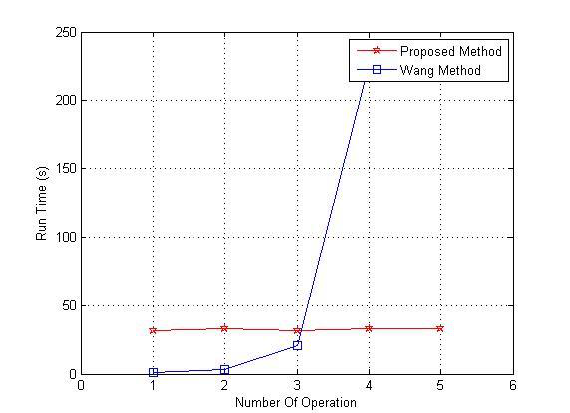
Figure 4. Comparison of runtimes in a different number of Web services.